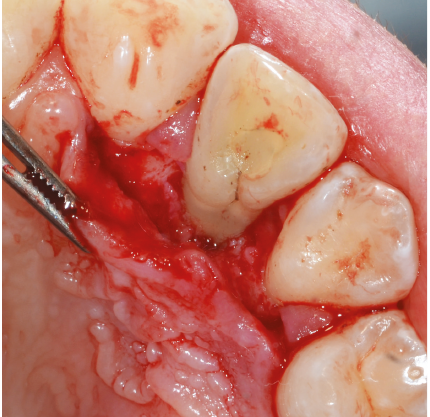
Figure 13: After a fl ap was re fl ected and direct visualization of the defect was obtained, debridement of the periodontal lesion was performed and the radicular groove was